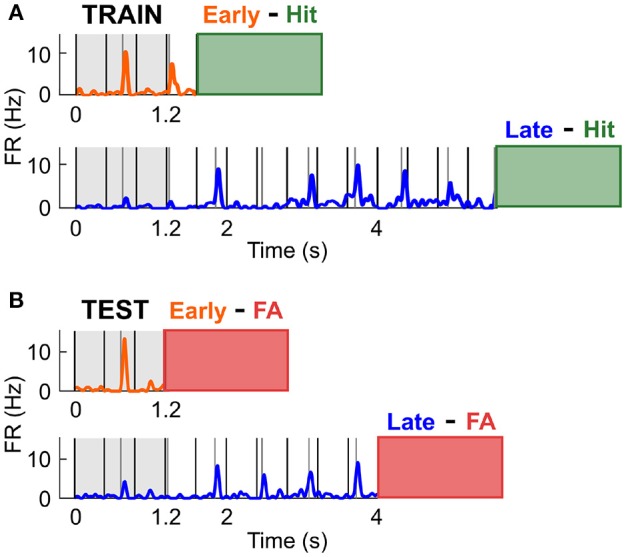
Predicting FA specificity using neural responses during Hit trials. (A) The activity in the 0–1.2 ms in Early and Late Hit trials (S2 condition only) was used to train the classifier in distinguishing between Early and Late responses. The orange and blue traces are the mean PSTHs in Early and Late Hit trials respectively, for an example cell tuned to the Low frequency. The green box at the end of the PSTH displays the time window in which the mouse generated Hit responses. (B) The activity in the 0-1.2 ms in Early and Late FA trials (S2 condition only) was used to test the classifier. The orange and blue traces are the mean PSTHs in Early and Late FA trials respectively, for the example cell in (A). The red box at the end of the PSTH displays the time window in which the mouse generated FA responses.